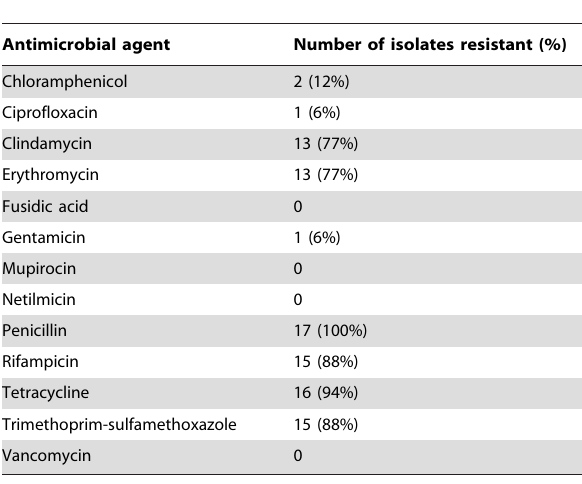
Table 1. Summary data for antimicrobial susceptibility profiles of 17 CA-MRSA